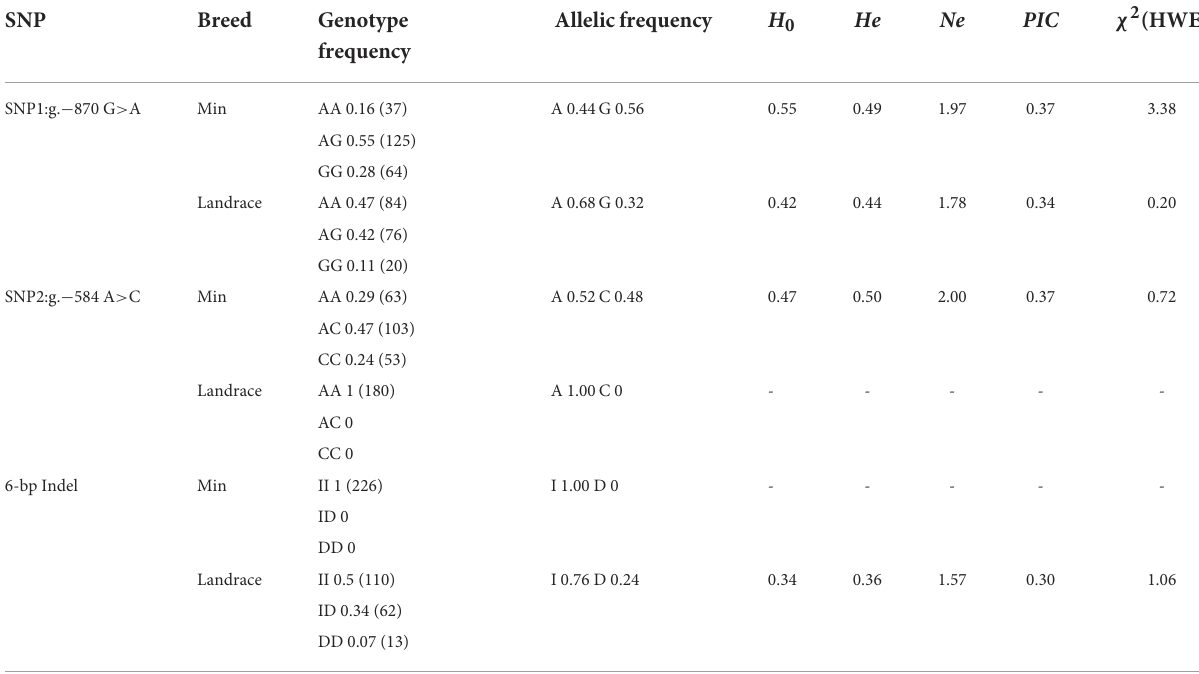
TABLE 2 Genotype and allelic frequency of SNP1, SNP2 and 6-bp Indel of STAT3 gene in Min pig and Landrace populations. SNP